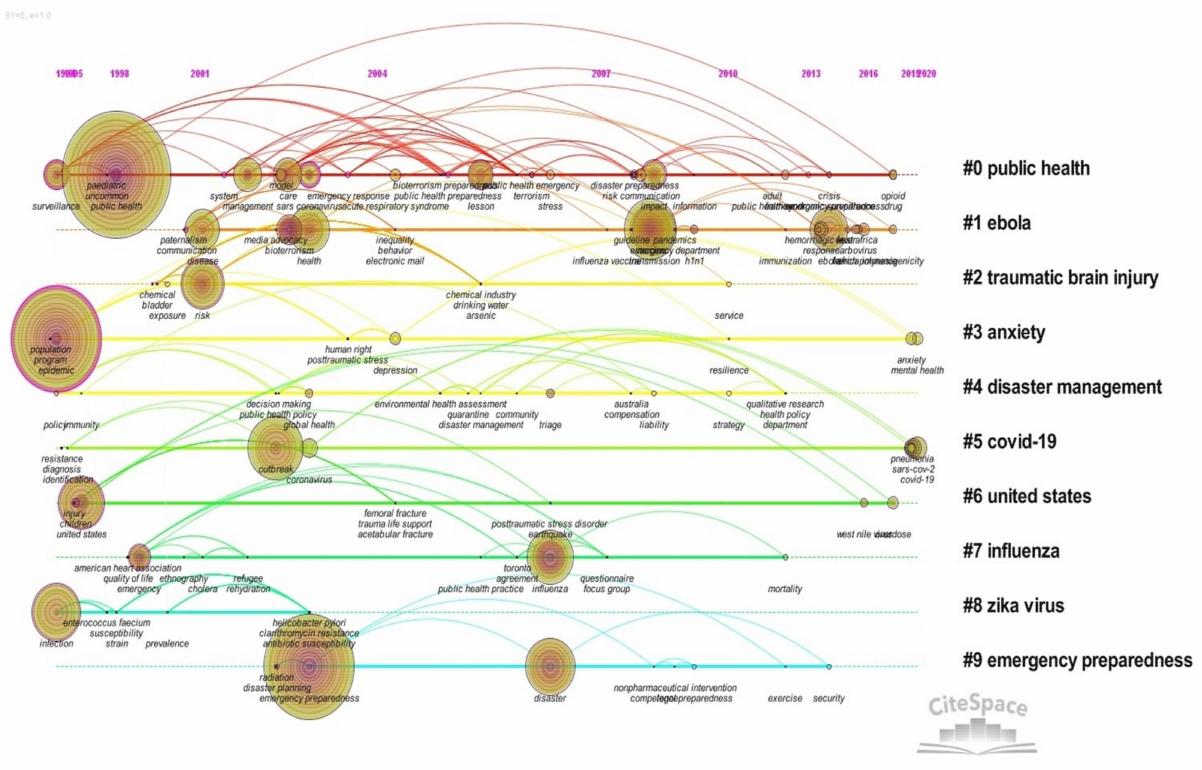
Figure 7. Timeline